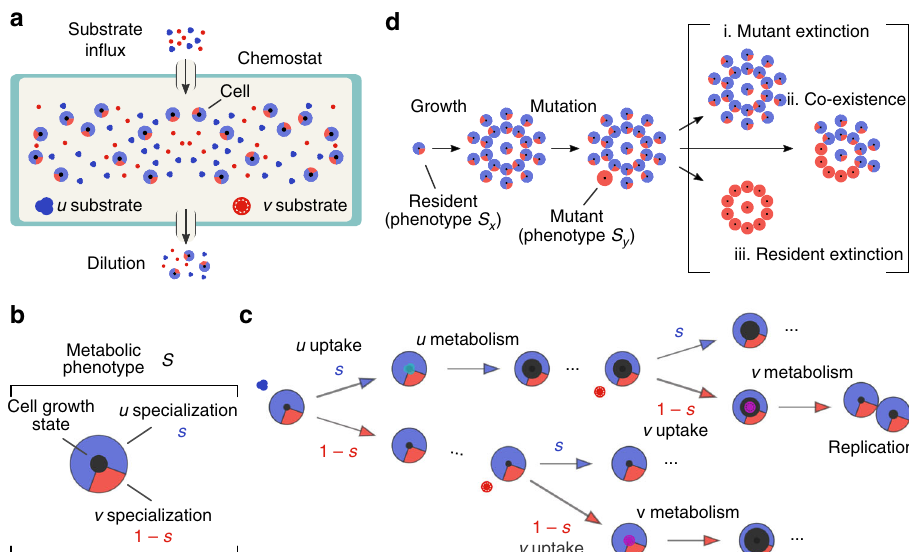
Fig. 1 Modeling microbial ecology in the chemostat with a metabolic trade-off between two substrates. a The chemostat is a homogeneous environment. The two substrates ( u and v ) are added continuously, and cells and substrates are diluted at a constant rate. b Cells specializing in using one substrate cannot also specialize in the other. The metabolic specialization of each cell is parameterized by a number, s , between zero and one: values near zero indicate a v -specialist; values near one indicate u -specialist; intermediate values are generalists. c To replicate, cells must progress through a series of discrete states of growth by metabolizing substrates. The yield of a substrate is the amount by which a cell ’ s state of growth increases by metabolizing the substrate. Cells replicate when their growth state exceeds a critical value. When a cell encounters a u substrate molecule, the molecule is imported with probability of s ; when a cell encounters a v substrate molecule, the molecule is imported with a probability of (1 − s ). d A rare mutation leads to competition between the (high abundance) resident phenotype and the (low abundance) invading phenotype and has three possible qualitative